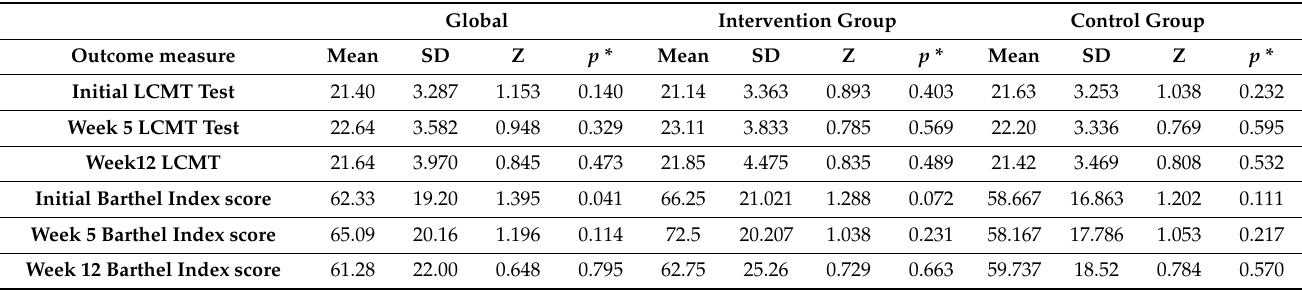
Table 2. Normality Tests.